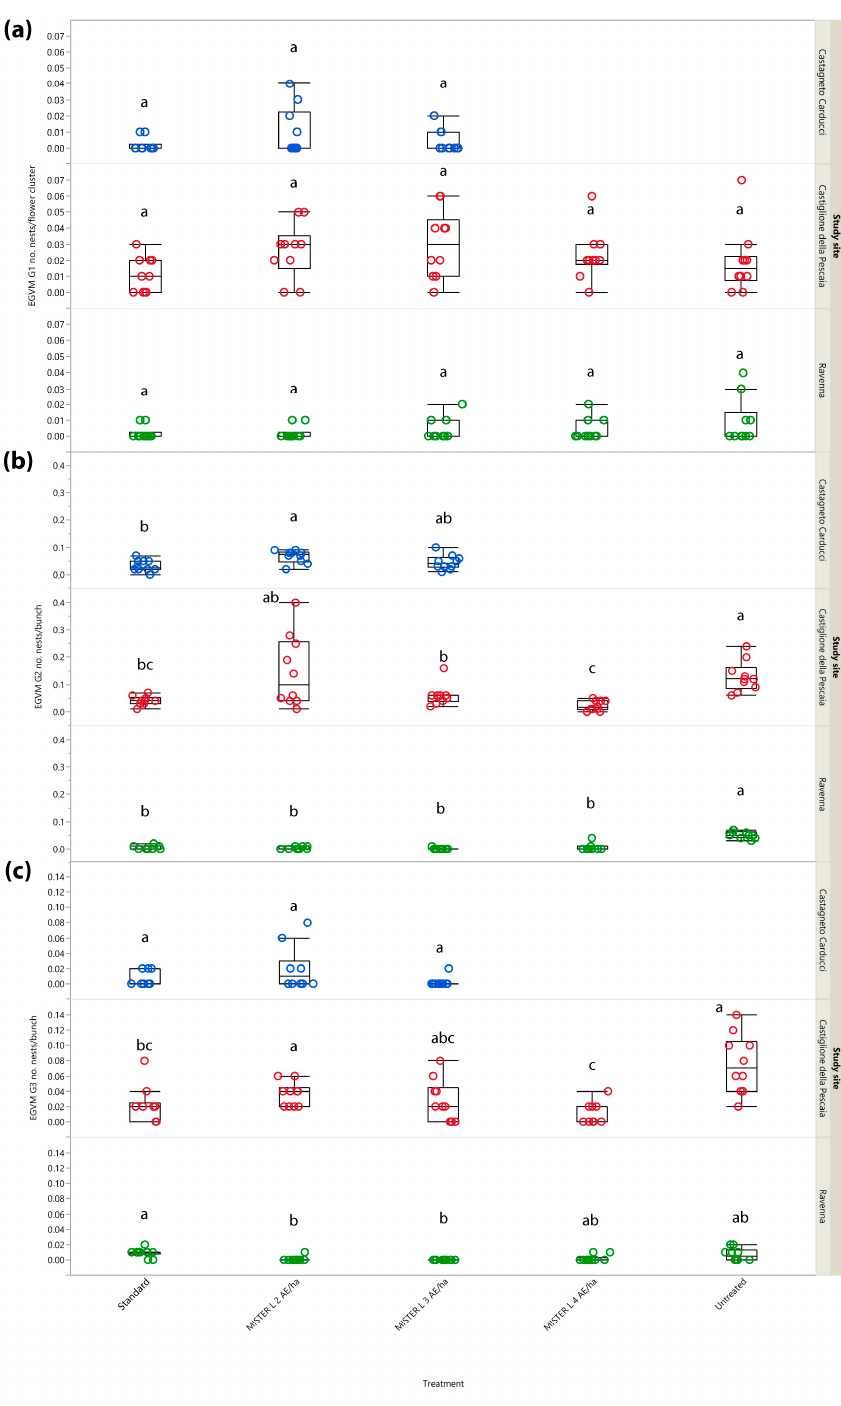
Figure 4. Impact of mating disruption using Isonet ® L MISTERX843 on the number of Lobesia botrana (EGVM) nests per flower cluster (G1) or bunch (G2 and G3) in Tuscany (Central Italy, in blue and red) and Emilia-Romagna (Northern Italy, in green) during 2017. Box plots indicate the median (solid line) within each box and the range of dispersion (lower and upper quartiles and outliers) of the infestation parameter. ( a ) G1: first generation; ( b ) G2: second generation; ( c ) G3: third generation (harvest). Within each generation and study site, different letters above box plots indicate significant differences between treatments (Kruskal–Wallis test followed by Steel–Dwass test, p < 0.05).